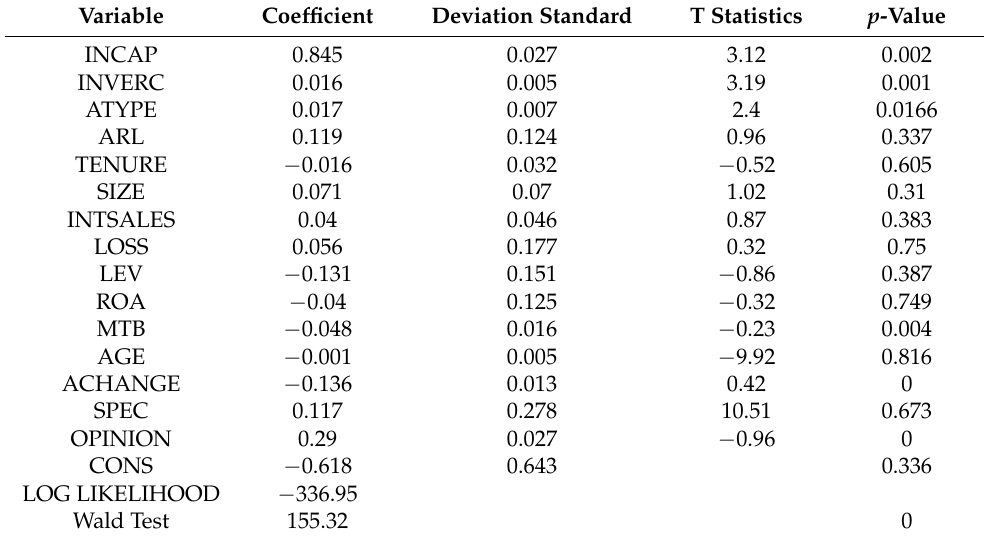
Table 9. The results of estimating the second model by the FGLS